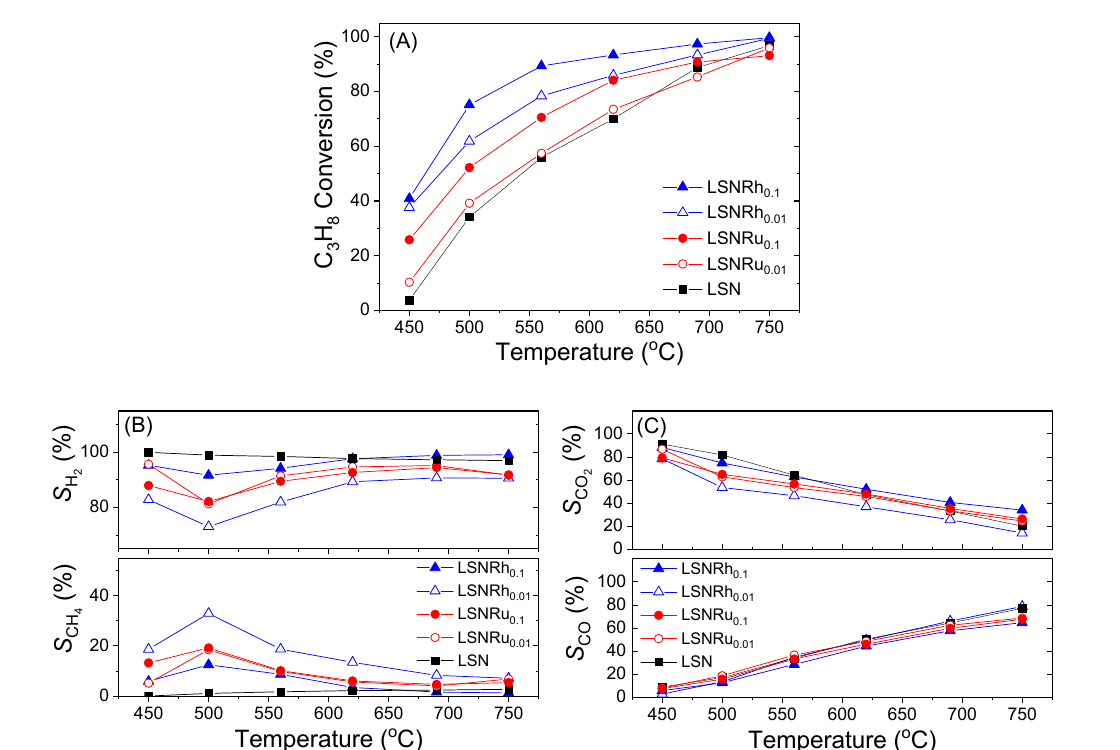
Figure 5. ( A ) Conversion of propane, ( B ) selectivities to H 2 and CH 4 , and ( C ) selectivities to CO 2 and CO obtained over the LSNRh x and LSNRu x catalysts. Experimental conditions: same as in Figure 3.